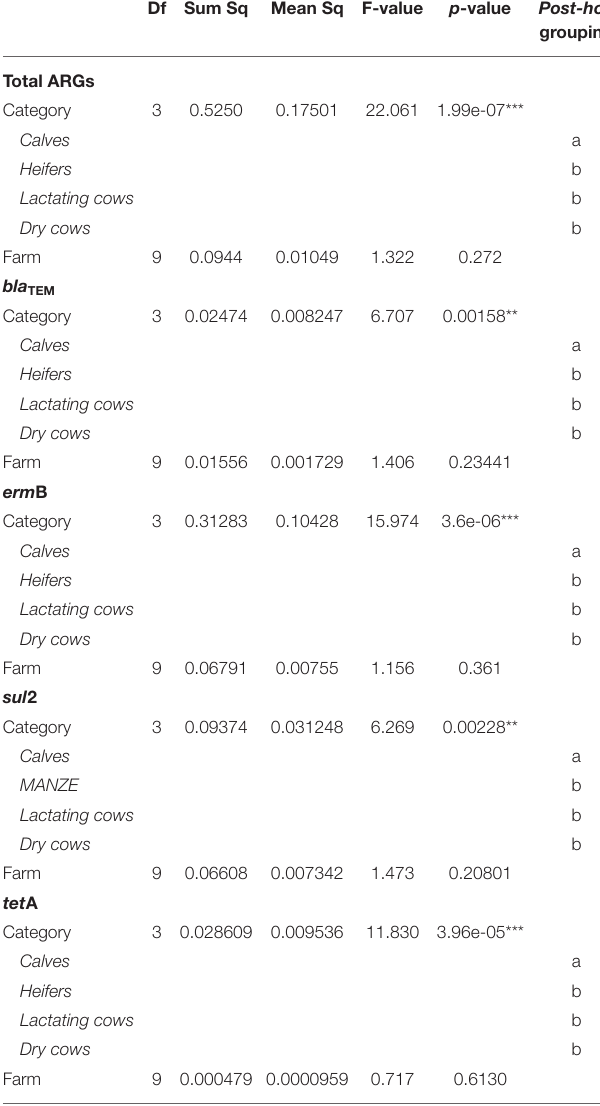
TABLE 2 | Statistical results for the analysis of variance (ANOVA) assessing the influence of the experimental variables (animal category and farm) on the normalized abundance of total antibiotic resistance genes (ARGs), bla TEM , erm B, sul 2, and tet